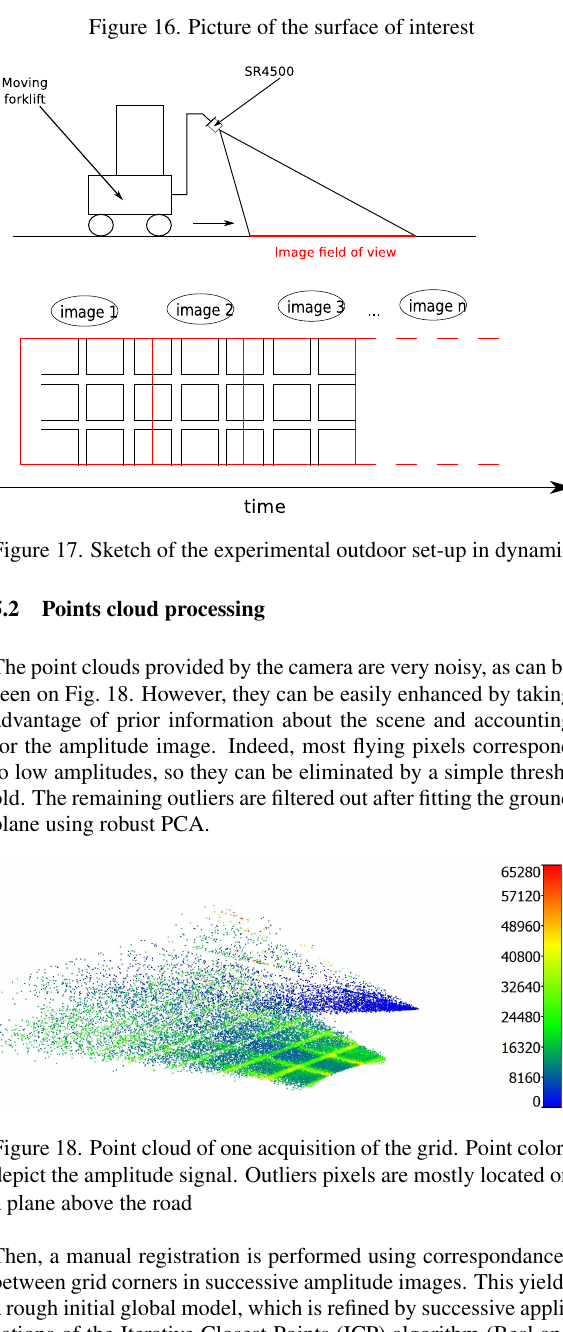
The image recording was done while the forklift moved at about 4 km.h − 1 .